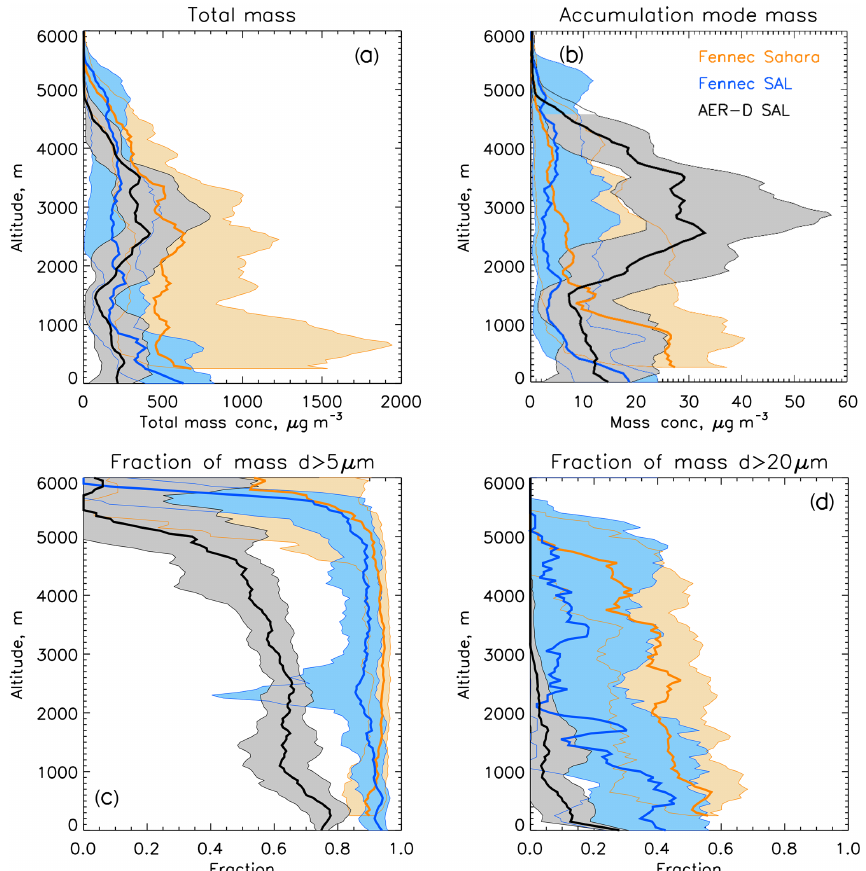
Figure 5. Vertically resolved mass concentrations for Fennec-Sahara (orange), Fennec-SAL (blue), and AER-D-SAL. (black) (a) Total mass concentration across all sizes measured; (b) accumulation-mode mass concentration d < 2 . 5µm; (c) and (d) fraction of mass at d > 5µm (c) and d > 20µm (d) . Bold lines and shading indicate the median and interquartile range, respectively. Data are smoothed over 250m intervals and for Fennec-Sahara are only available down to 350m due to flight